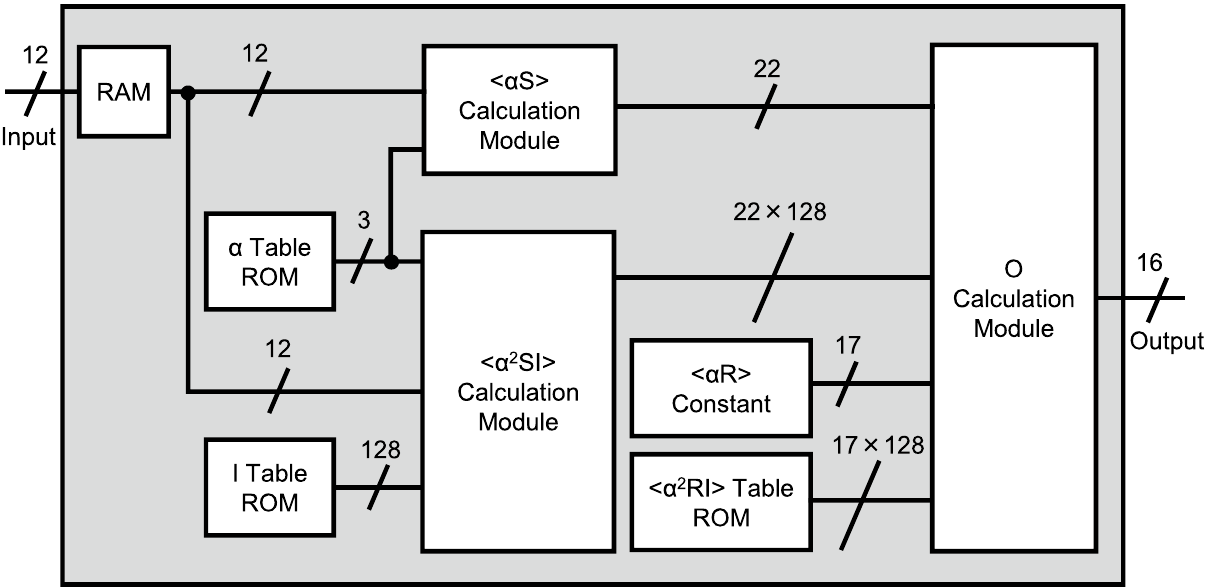
Figure 2. Block diagram of the reconstruction circuit. The number of encoding mask patterns can be up to 1024. The numbers above diagonal lines indicate the bit width of a signal. The reconstruction circuit comprises three calculation modules and lookup tables. We implemented 128 modules for (cid:31) α 2 SI (cid:30) calculation and O calculation for parallel